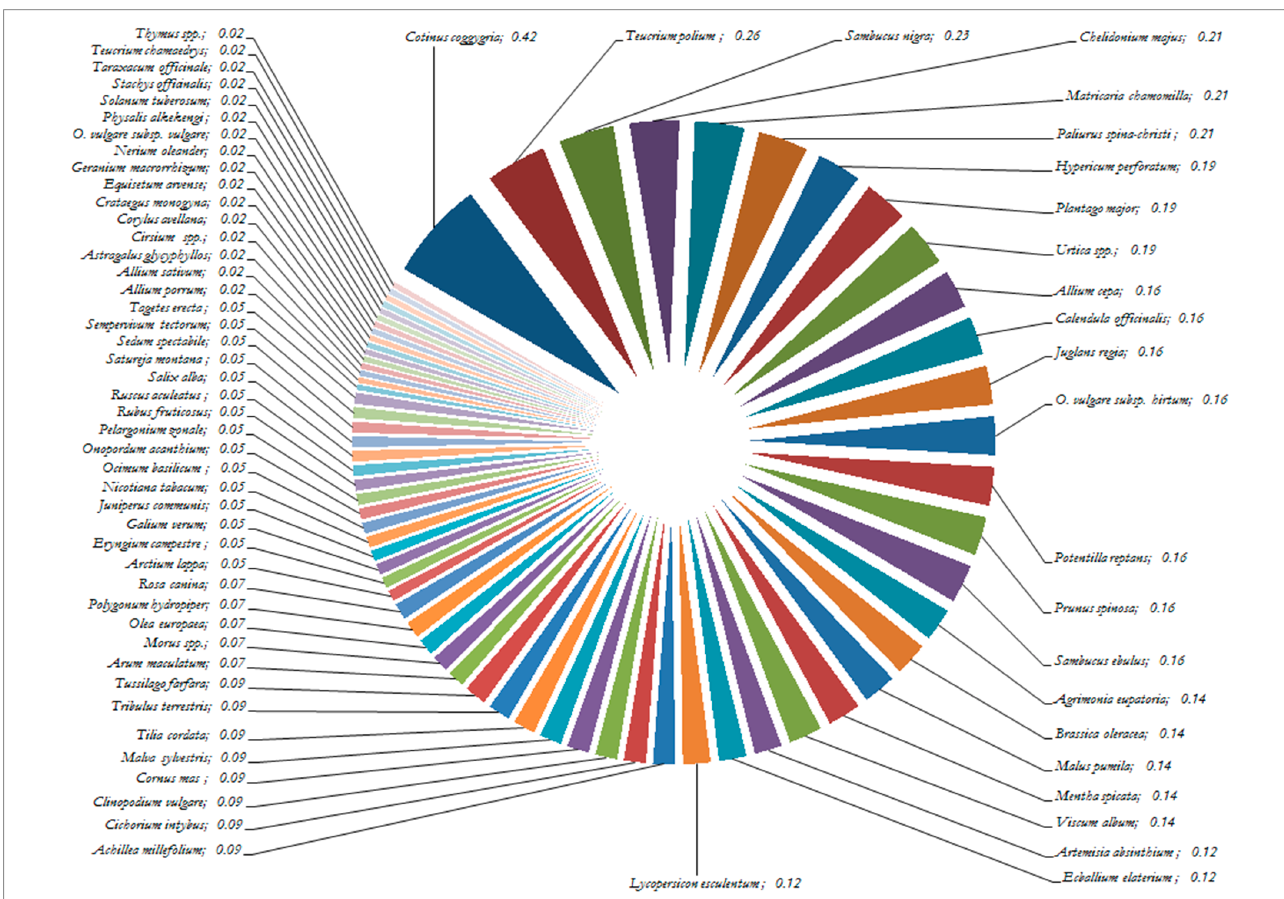
Figure 11. Plant species used for human health conditions in the East Rhodopes according to the value of the UV index.